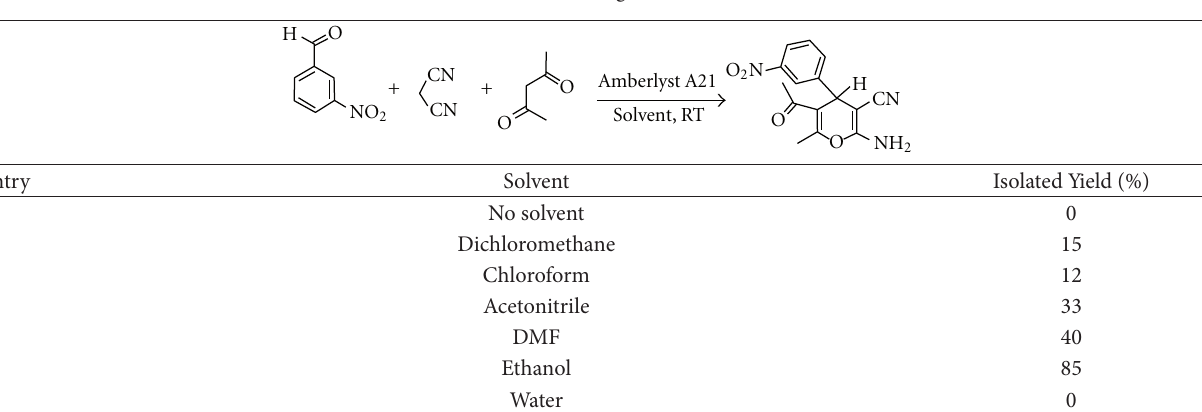
T 2: Optimization of catalyst loading. a